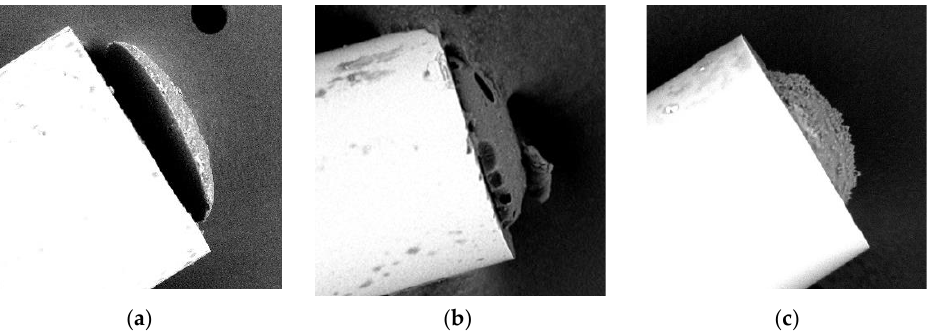
Figure 9. SEM images illustrating technological issues of the microtips manufacturing process: ( a ) partial delamination, ( b ) gas bubbles, and ( c ) compounds aging. ( a ) partial delamination, ( b ) gas bubbles, and ( c ) compounds